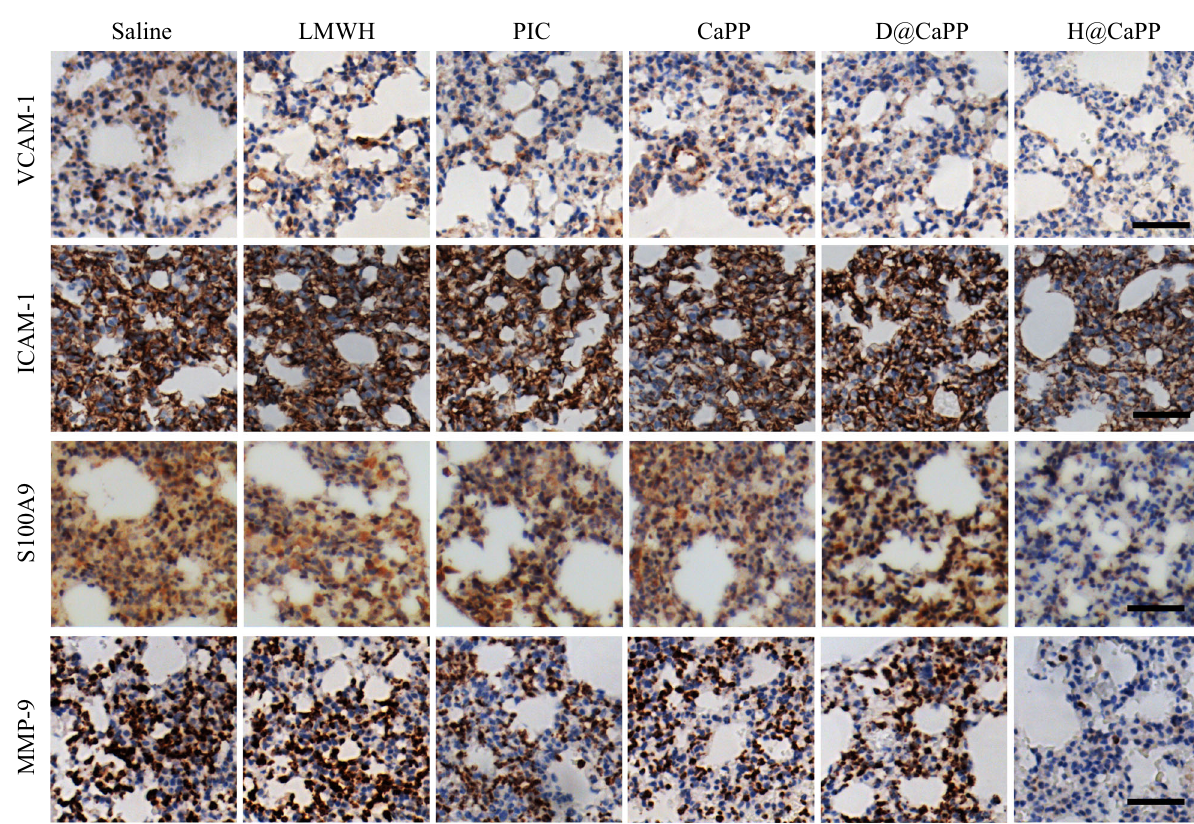
Fig. 8 H@CaPP inhibited the formation of a pre-metastatic microenvironment in vivo. Representative images of immunohistochemical analysis of ICAM- 1, VCAM-1, MMP-9, and S100A9 (brown) in the lung of breast tumor-bearing mice after intravenously administrated with saline, LMWH, piceatannol, CaPP, D@CaPP, or H@CaPP (i.v. at a dose of piceatannol or PP at 0.020 mmol/kg, at a dose of Dextran or LMWH at 10 mg/kg) for seven times in 14 days. Scale bar, 50 μ